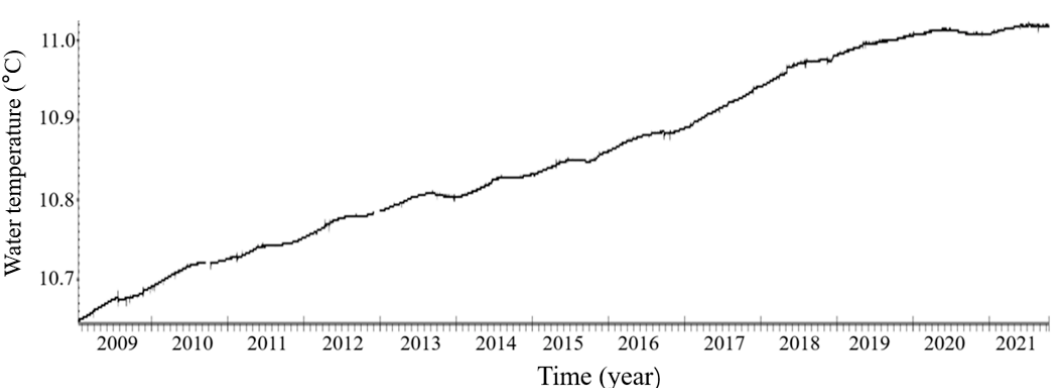
Figure 9. Long-term observation curve of water temperatures at the Lhasa geomagnetic station from 15 January 2009 to 13 October 2021.